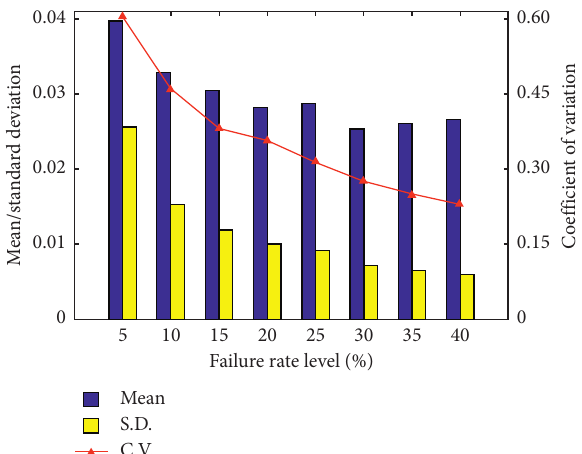
Figure 8: Average mean, S.D., and C.V. of FDR per failure for eight bus stops.